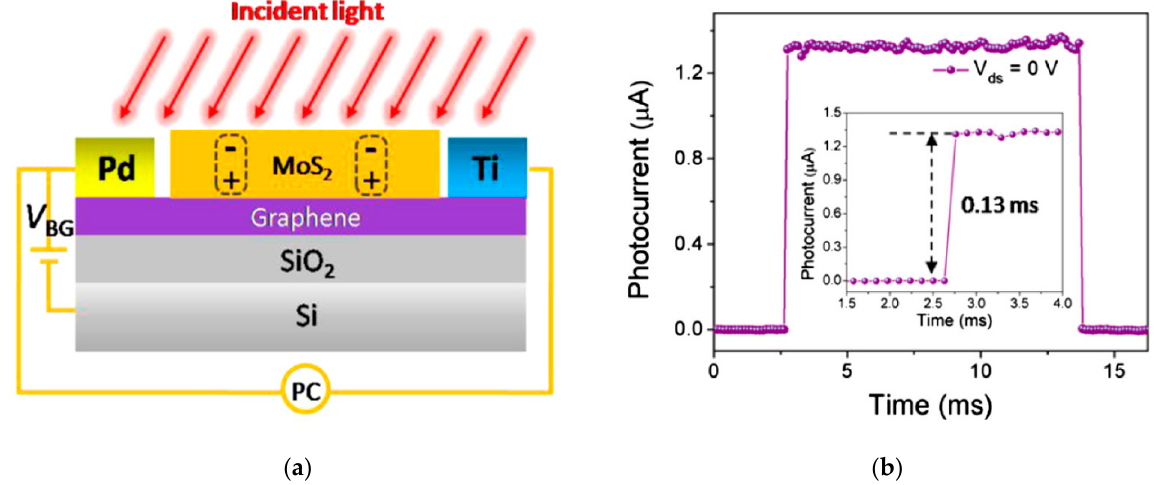
Figure 16. ( a ) Scheme of a phototransistor based on a graphene-MoS 2 heterostructure. ( b ) Time-resolved response of the phototransistor (Vds = 0 V). Reprinted with permission from ref. [31]. © 2015, Elsevier.